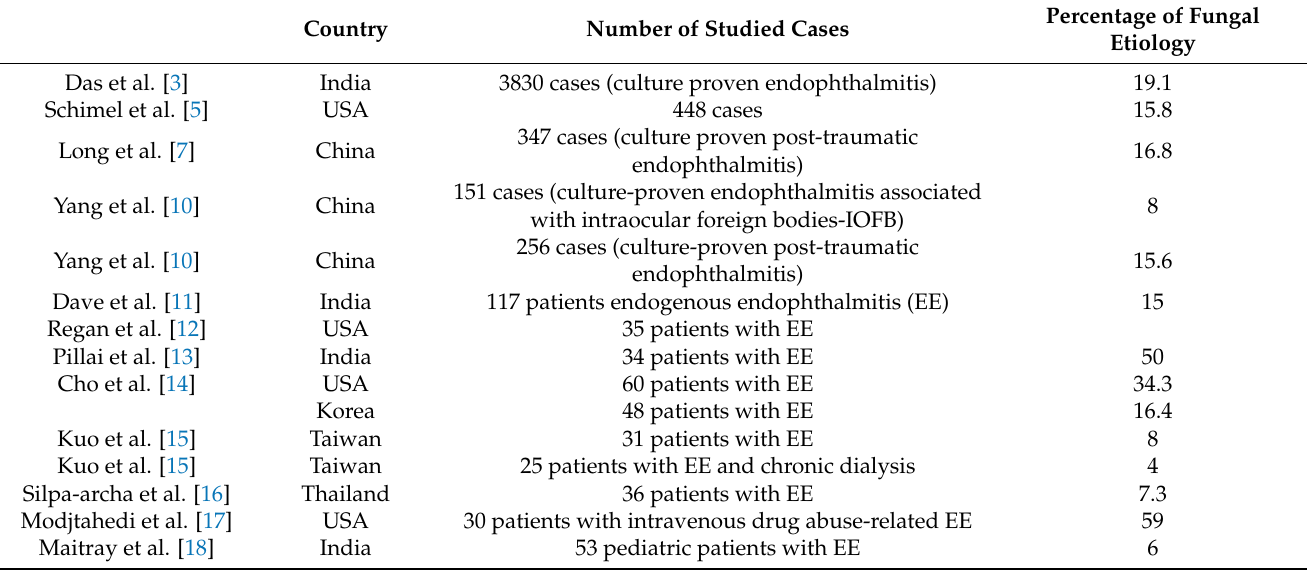
Table 1. The prevalence of fungal